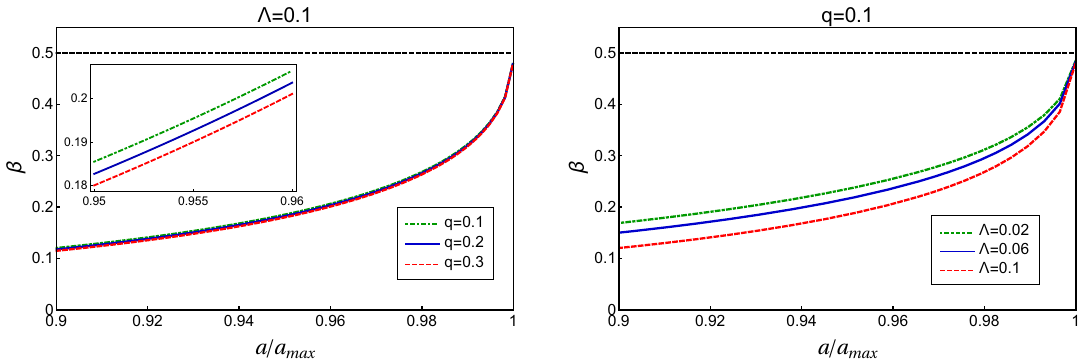
Figure 6 . The variation of the parameter (cid:12) against the normalized rotation parameter ( a=a max ), with a max denoting the maximal rotation, for rotating black hole in four dimensional brane for di(cid:11)er- ent values of q (left corner) and (cid:3) (right corner) have been presented. In each plot, the black dashed line corresponds to the limiting case (cid:12) = 1 = 2. As evident both of these plots indicate that cosmic censorship conjecture is respected in a rotating black hole spacetime in the four dimensional brane.